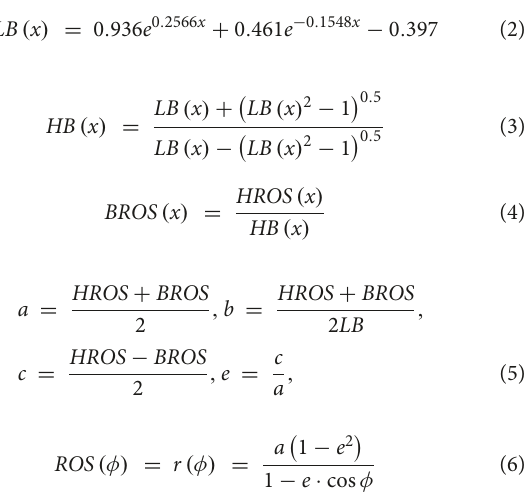
(4) below, and the ROS in any other direction using the elliptical fire growth model formulated by Eqs. (5) and (6).